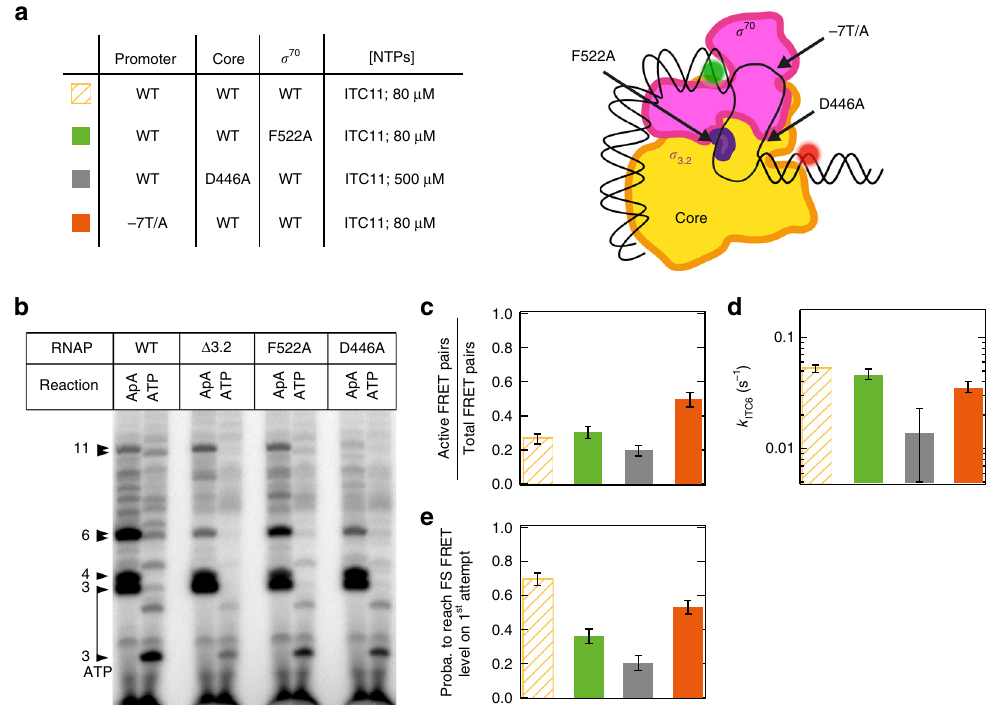
Fig. 3 Core and σ 70 mutants affect ITC6 pause exit probability. a Experimental conditions studied here and schematic of the different RP complex variants, all with ApA starting substrate. The same experiments have been performed with ATP starting substrate and are presented in Supplementary Fig. 2e, f, g. b Bulk reaction performed with a consensus lac promoter (Supplementary Fig. 1a) and different holoenzyme mutants, in ITC11 NTP conditions (500 µ M ApA and 80 µ M ATP/UTP/GTP or 500 µ M ATP and 80 µ M UTP/GTP) and 1 min incubation at 37 °C (the experimental procedure is described in the Supplementary Information). The band assignment is indicated on the left hand side of the gel. c The fraction of transcriptionally active RPs, which displayed NTP-dependent E FRET changes, of all surface-immobilized RPs (see also, Methods: FRET pair localization and detection), in the experimental conditions described in a . d ITC6 pause exit rate for the experimental conditions described in a . e Probability to reach the FS FRET level on the fi rst attempt for the experimental conditions described in a . Error bars are either 1 SD from 1000 bootstraps procedure d or 95% con fi dence interval c ,